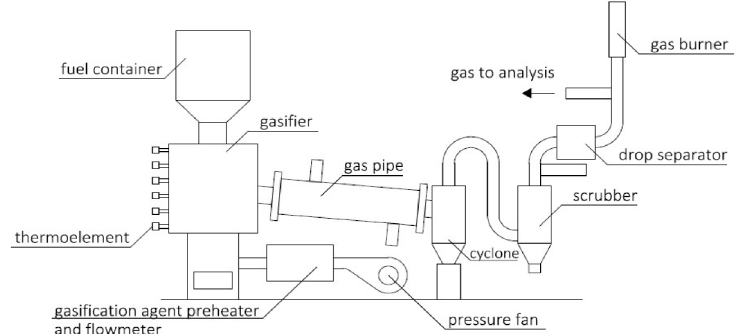
Fig. 1. Scheme of the experimental system.